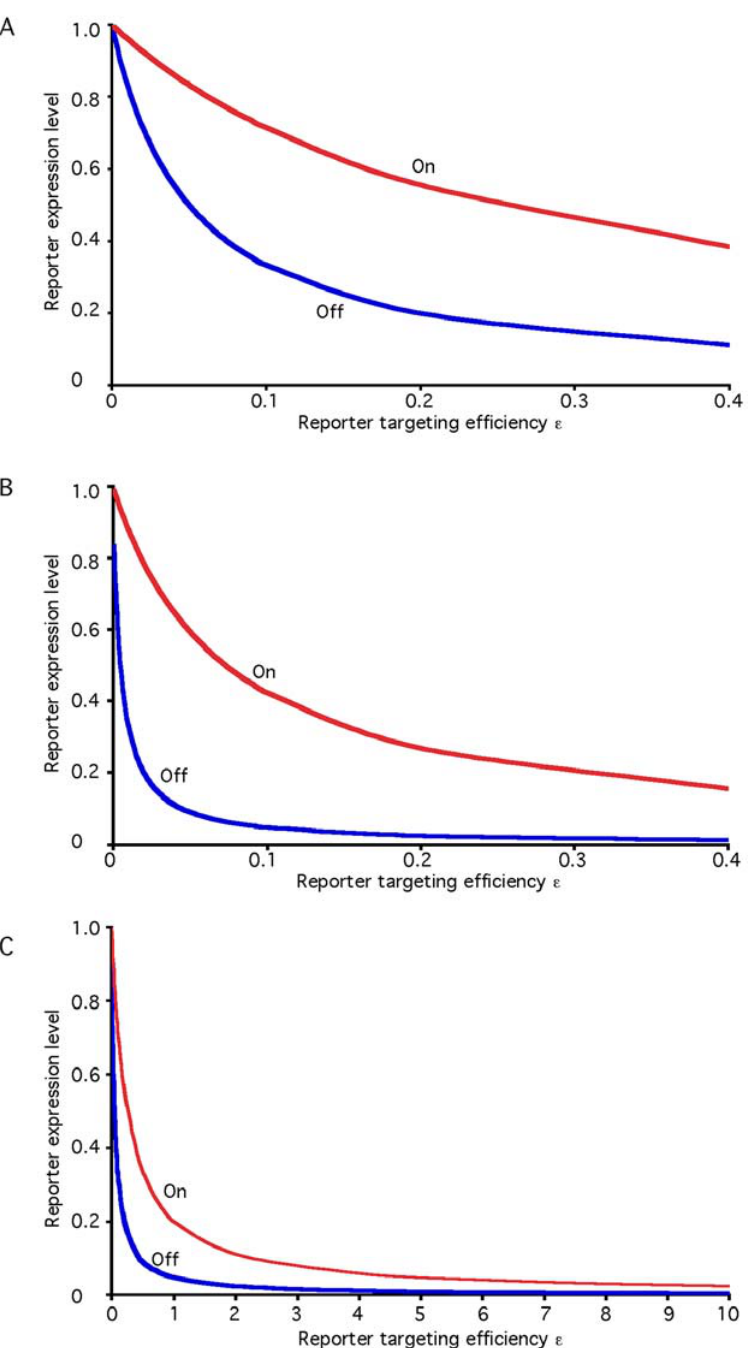
Figure 6. Improving performance of switch-off/switch-on experiments by unequal efficiency of targeting Dicer and Reporter. In each graph the red curve shows reporter level when Dicer is targeted (switch-on state), and the blue curve shows reporter level when Dicer is not targeted (switch-off state). Results are plotted as a function of the efficacy with which the reporter is targeted by the siRNA (defined by parameter epsilon) relative to the efficacy with which Dicer is targeted. The first two graphs show results predicted for different values of overall RNAi efficacy parameter gamma. (A) gamma=20. (B) gamma=200. (C) shows results for gamma=20 over an extended range of targeting efficacy epsilon, with values greater than 1 indicating that the reporter is targeted with higher efficiency than